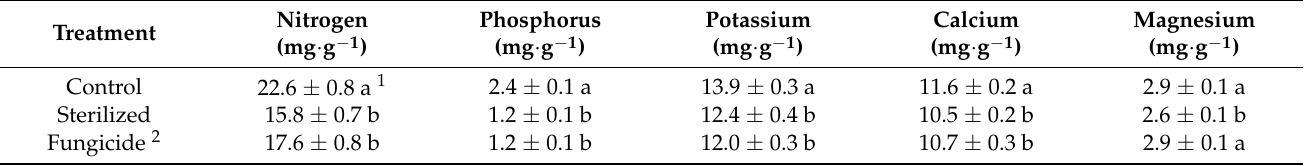
Table 7. The influence of growing Serianthes grandiflora , Serianthes kanehirae , and Serianthes nelsonii